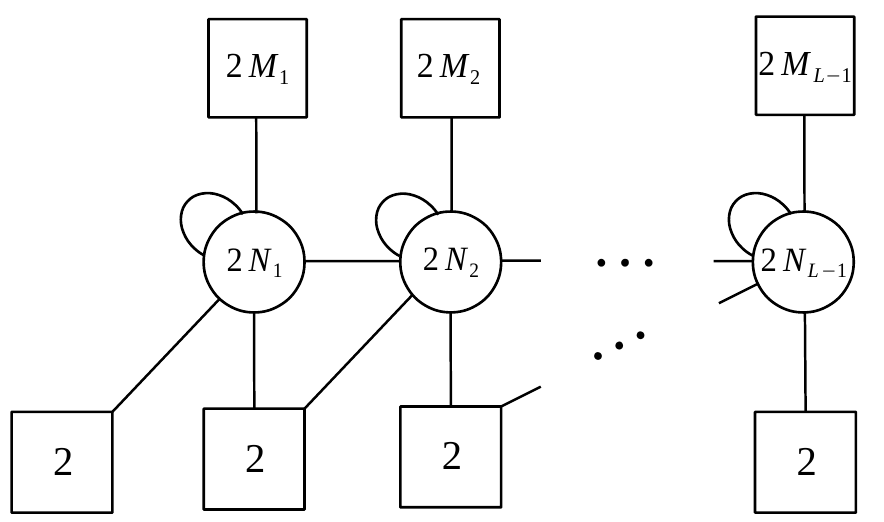
Figure 7 . Schematic structure of the E (cid:26)